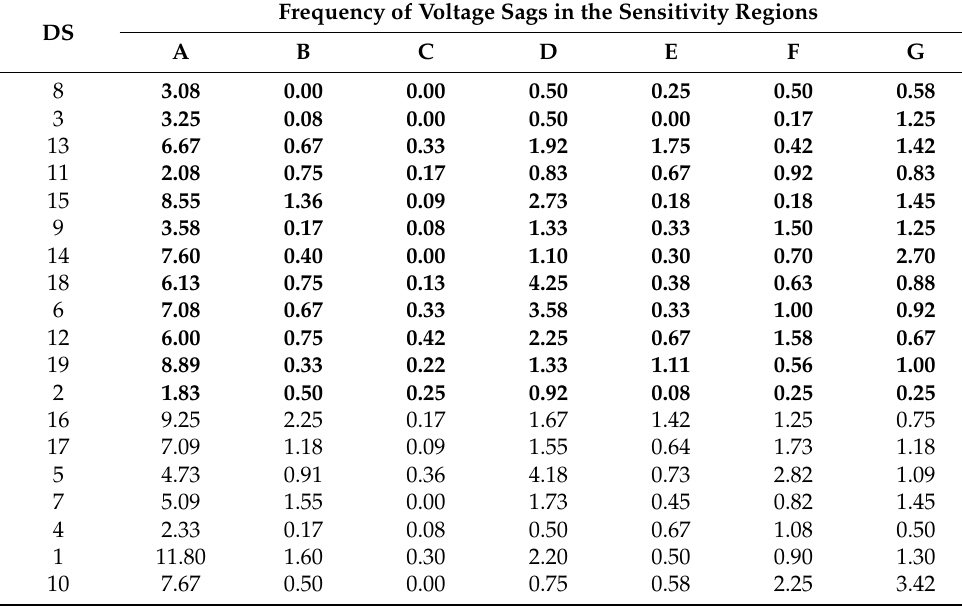
Table 7. Frequency of voltage sags in the sensitivity regions.